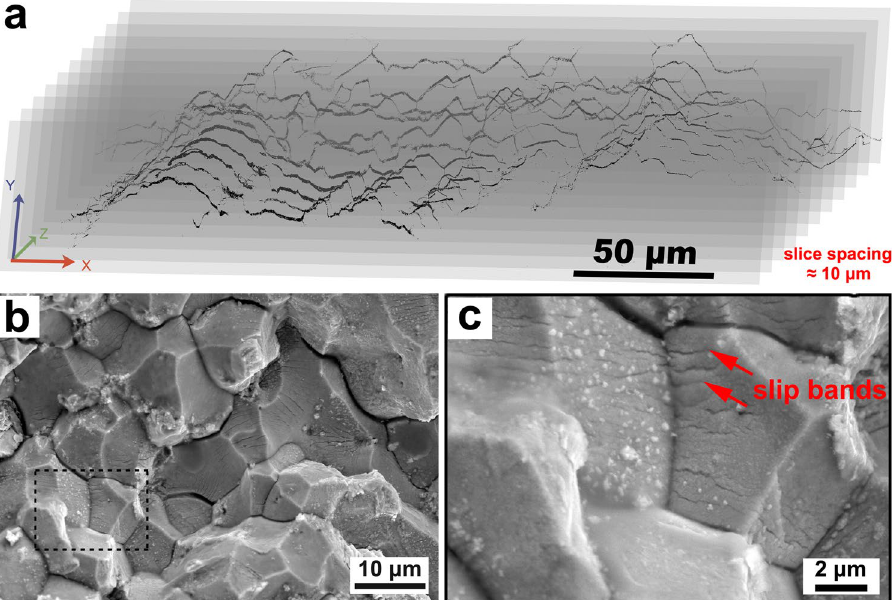
Figure 3. 3D morphological reconstruction of the crack plane and its SEM characterization. ( a ) Slices reconstruction of the crack with the slice-spacing of ~10 μ m. ( b ) Low magnification image of the crack plane, with sharp crystal facets. ( c ) The high magnification topography of the dashed area ( b ), exhibiting nano sized precipitates and slip bands (red